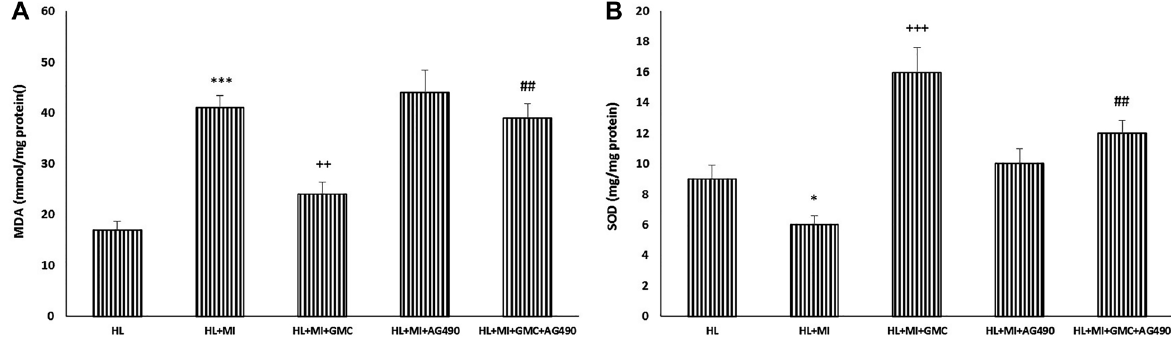
Figure 5: The effects of GMC administration on the levels of MDA (A) and SOD (B) following myocardial ischemia-reperfusion injury and their reversal by AG490 in hyperlipidemic (HL)